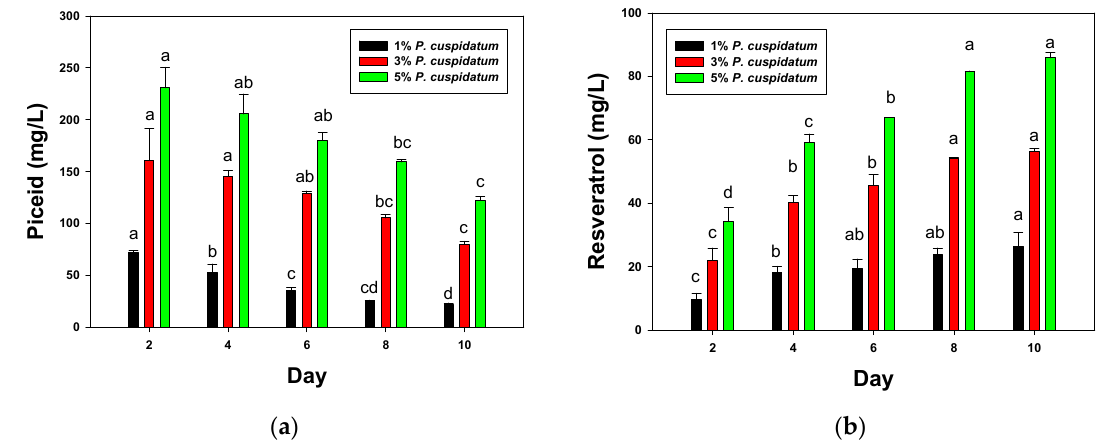
Figure 3. Effect of P. cuspidatum roots on the ( a ) piceid and ( b ) resveratrol yields during rice wine fermentation. a,b,c,d When the bars of the same color have significant differences at p -value less than 0.05, homogeneous groups in each variable are identified by the same superscript letter according to the LSD (least significant difference) test.